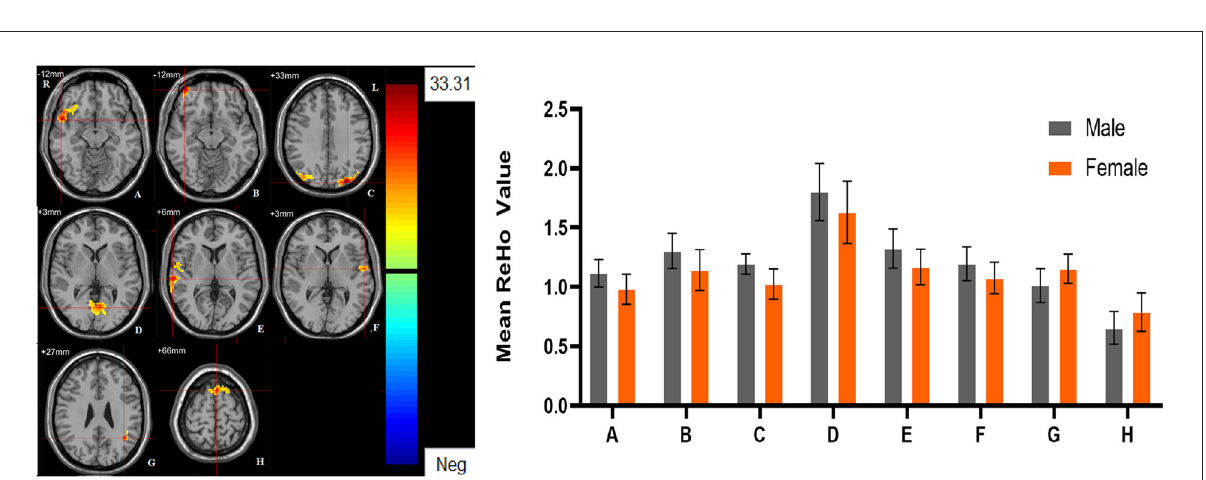
FIGURE5 The main effect of sex group. Regions with a main effect of sex group included (A) The right orbital inferior frontal gyrus; (B) The right orbital middle frontal gyrus; (C) The left middle occipital lobe, and the right postcentral gyrus; (D) The bilateral lingual gyrus and the bilateral calcarine; (E) The right superior temporal gyrus; (F) The left superior temporal gyrus; (G) The left middle temporal gyrus; (H) The left dorsolateral Superior frontal gyrus (cluster-level threshold of p < 0.05 after GRF correction). The color bar represents the range of F values. R = right, L = left. The graph shows the ALFF values (mean ± standard deviation) extracted from regions with a main effect of sex group. The Y-axis represents ALFF values. The X-axis represents regions with a main effect of sex